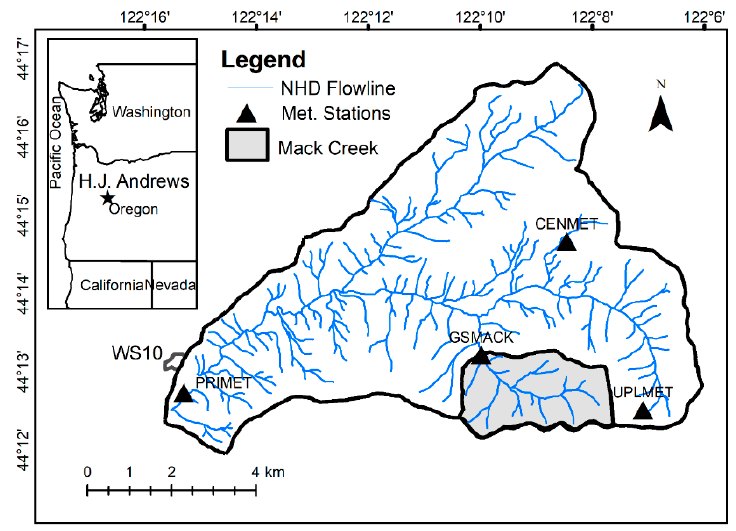
Figure 1. Location of Mack Creek Catchment within the H.J. Andrews Experimental Forest in Western Oregon. Black triangles indicate the locations of the meteorological stations (PRIMET, CENMET, and UPLMET) along with the location of the precipitation and stream gauging stations at Mack Creek (GSMACK).